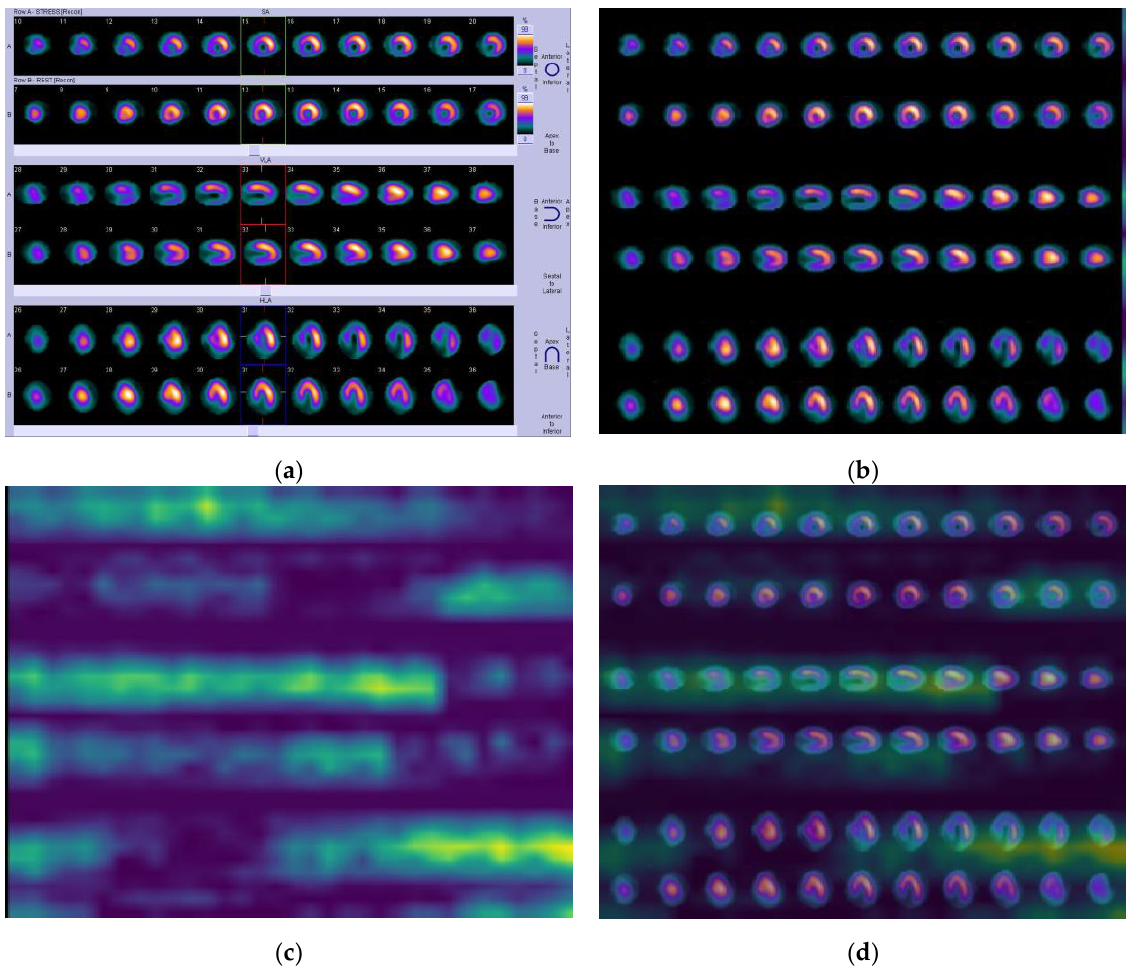
Figure 7. Ischemia — Case B. ( a ) Initial image; ( b ) processed image; ( c ) heatmap; and ( d ) visualized results generated by Grad-CAM.